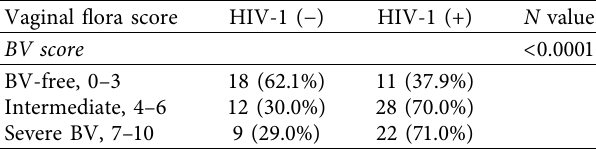
Table 2: Prevalence of BV score using Nugent’s criteria and HIV